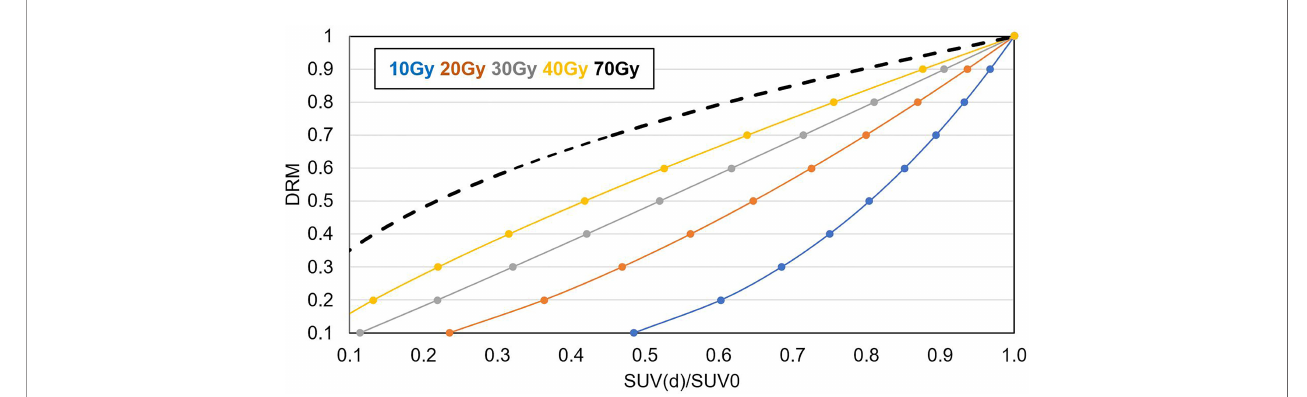
FIGURE 5 | Relationship between SUV(d)/SUV 0 and DRM for d = 10, 20, 30, 40, and